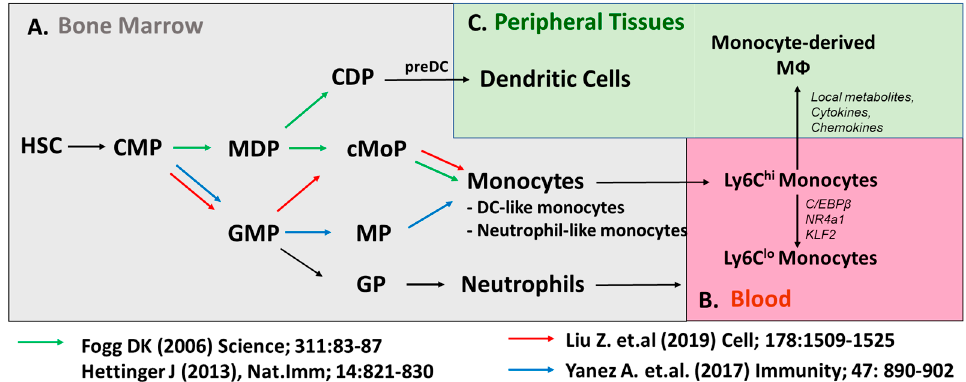
Figure 1. Developmental heterogeneity of monocyte populations. ( A ) Classical model (green arrow) of monocyte development shows monocytes are generated through Macrophage (M ϕ ) and DC Precursors (MDPs). Emerging evidence (red, blue arrows) suggest monocytes can be generated through the Granulocyte and Macrophage Progenitors (GMPs). Ly6C hi monocytes give rise to Ly6C lo monocytes in ( B ) blood or monocyte-derived macrophages in ( C ) peripheral tissues.